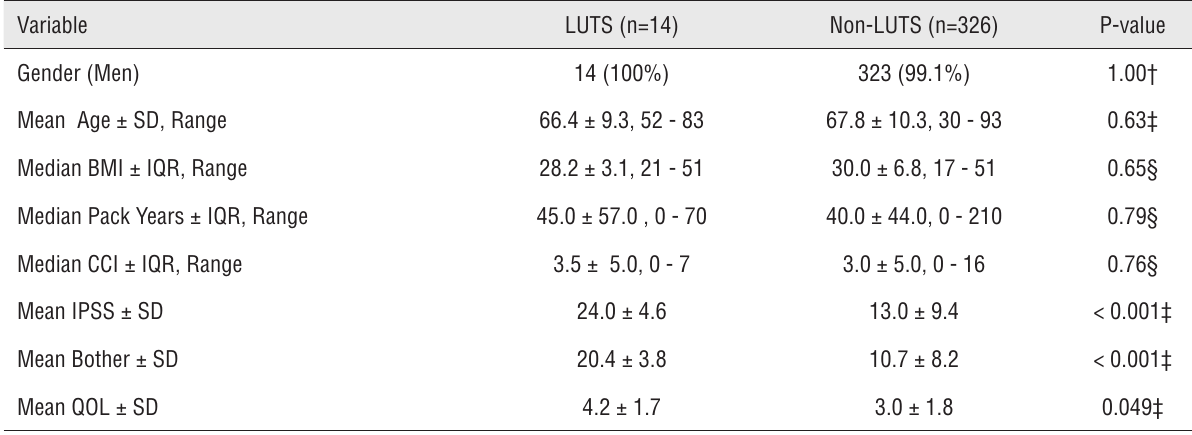
Table 1 - Demographic and clinical presentation for LUTS and Non-LUTS patient groups. Variable